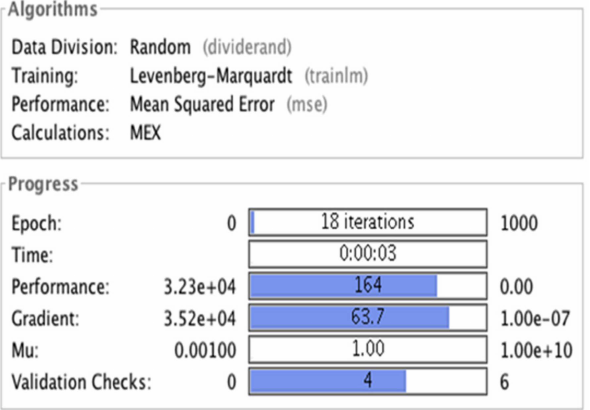
Figure 5. ANN model training of model one.